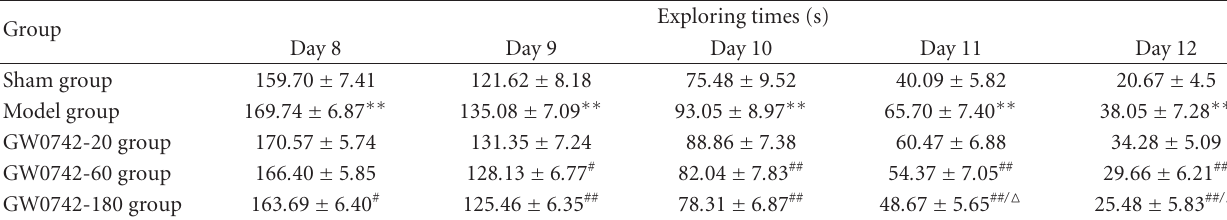
Table 1: E ff ect of GW0742 on the exploring time of rats after GCIRI.